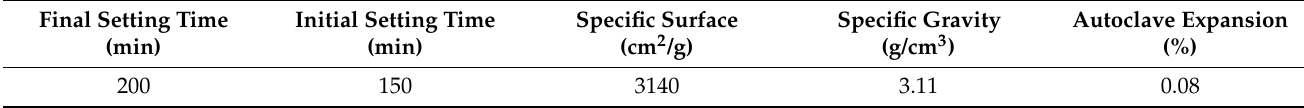
Table 1. Physical properties of cement.